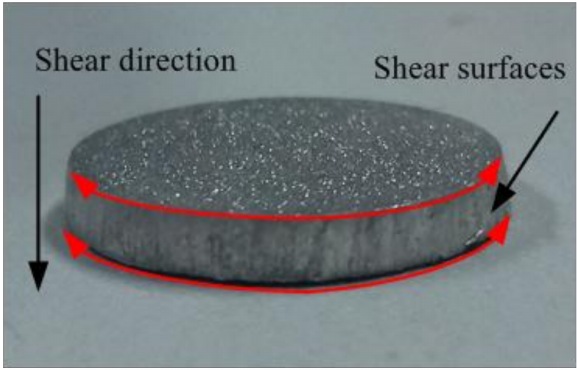
Figure 6. Diagram of the shear surfaces in TD.